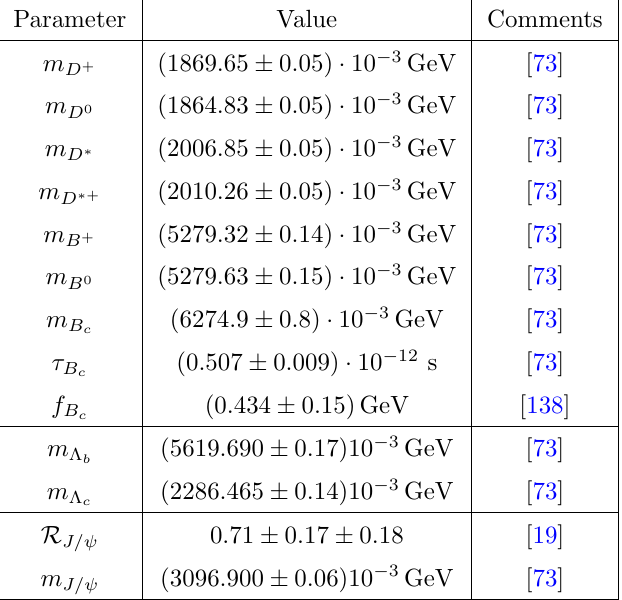
Table 10 . Experimental inputs used in the analysis.